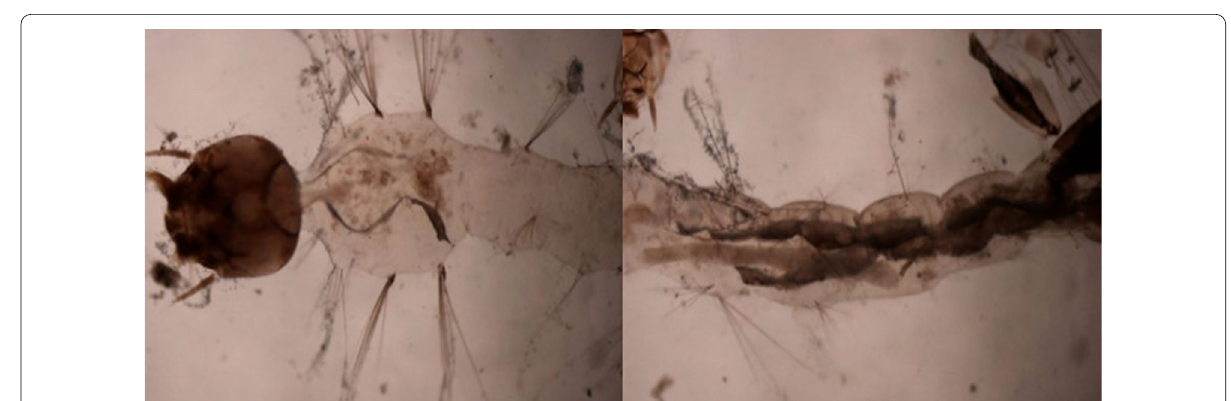
Fig. 8 Larvicidal activity of CuNPs (20 mg/ml)